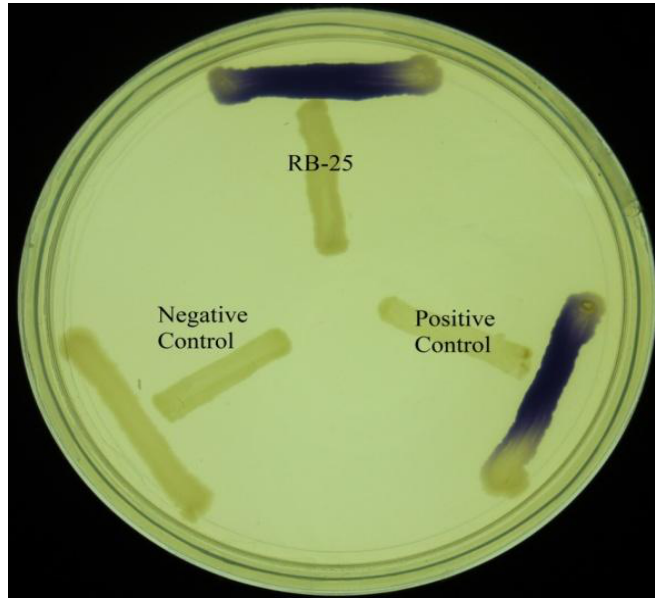
Figure 1. AHL production by strain RB-25. Purple pigmention observed in C. violaceum CV026 after overnight incubation when strain RB-25 was cross streaked with CV026 colony. E . carotovora GS101 was included as positive control while E . carotovora PNP22 was included as negative